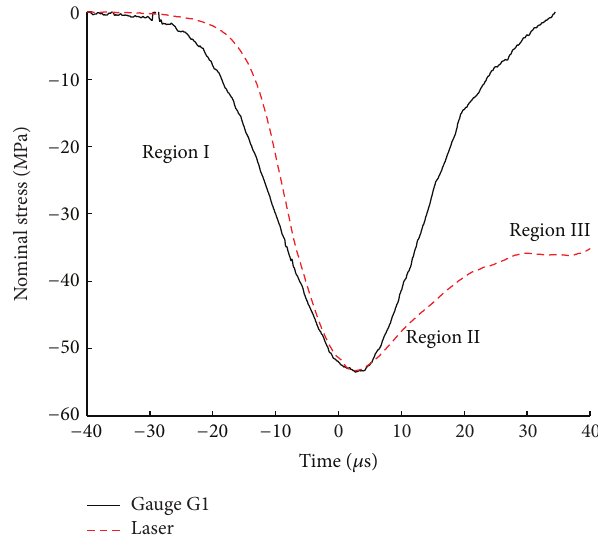
Figure 5: Nominal stress obtained from gauge G1 ( 𝐸𝜀 ) and based on rear face velocity ( (1/2)𝜌𝐶 0 𝑉 ) in a specimen with preexisting structural